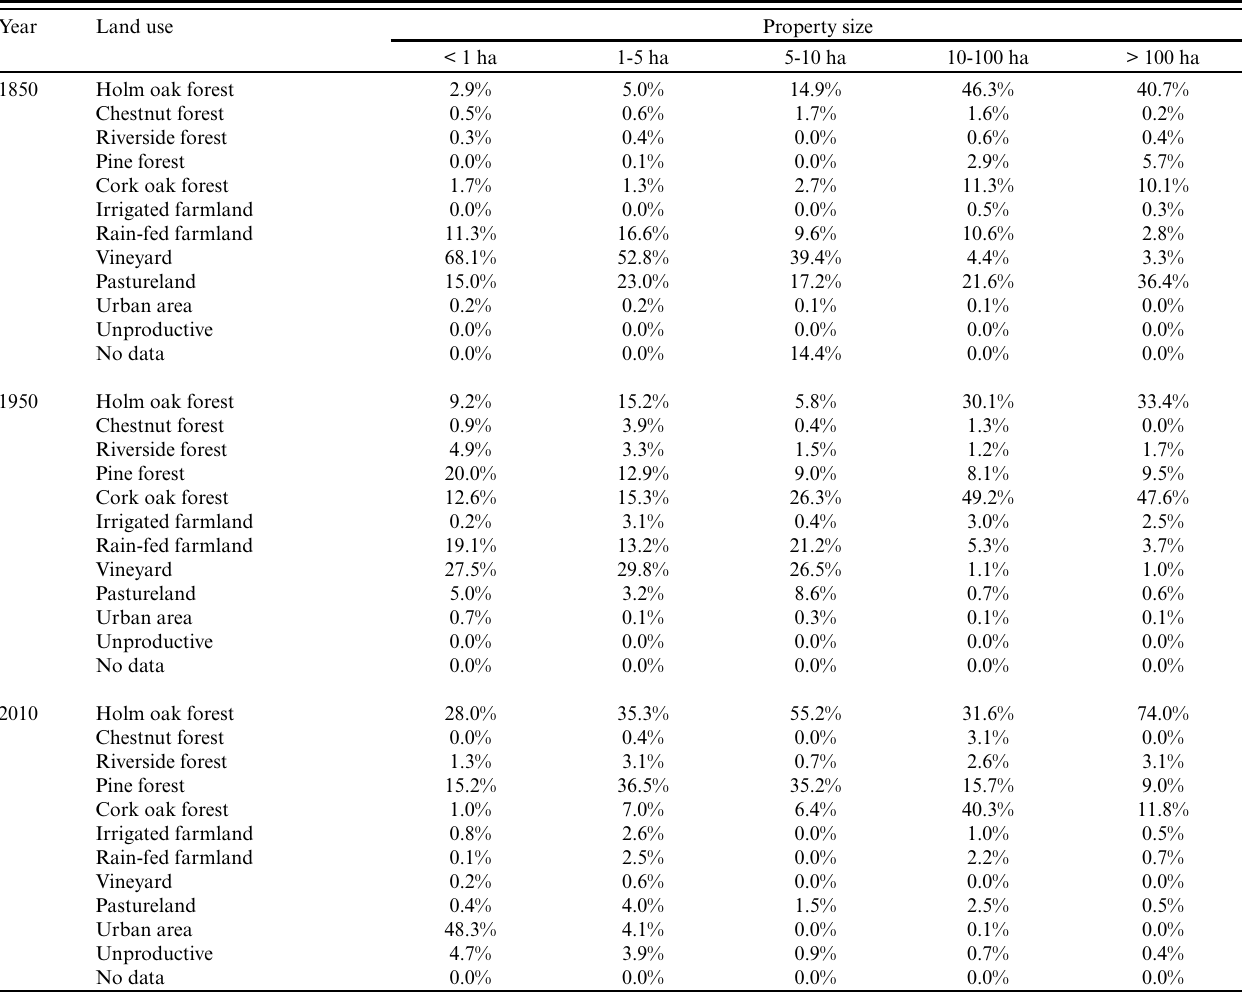
Table 7 . Relative area of land uses according to property size for years 1850, 1950, and